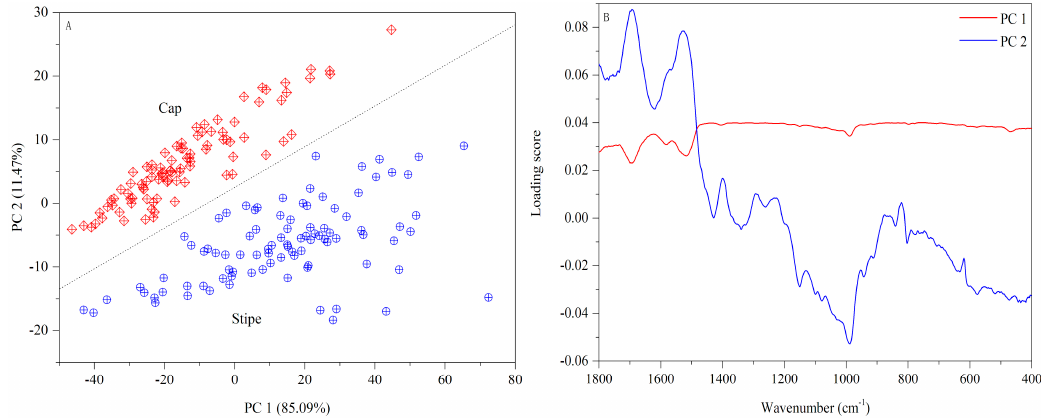
Figure 5. PCA result based on FT-MIR spectra (( A ) Score plot; ( B ) Loading plot).